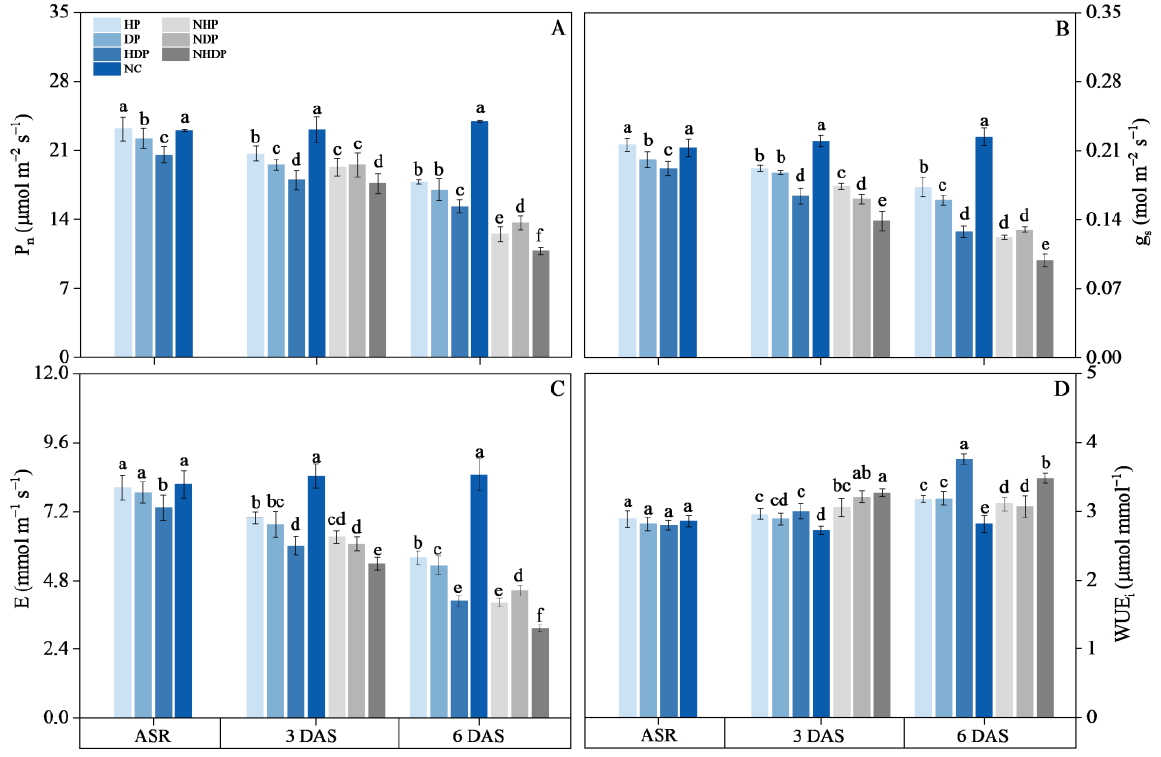
Figure 4. Effects of stress priming on the photosynthesis rate ( P n , A ), stomatal conductance ( g s , B ), transpiration rate ( E , C ), and instantaneous water use efficiency (WUE i , D ) of seedlings under stress conditions. HP, heat priming + later heat stress; DP, drought priming + later drought stress; HDP, combined stress priming + later combined stress; NHP, no heat priming + later heat stress; NDP, no drought priming + later drought stress; NHDP, no combined stress priming + later combined stress; NC, no stress priming + no later stress. The bars represent means ± SD (n = 10), where different letters designate significant differences at the 0.05 level.